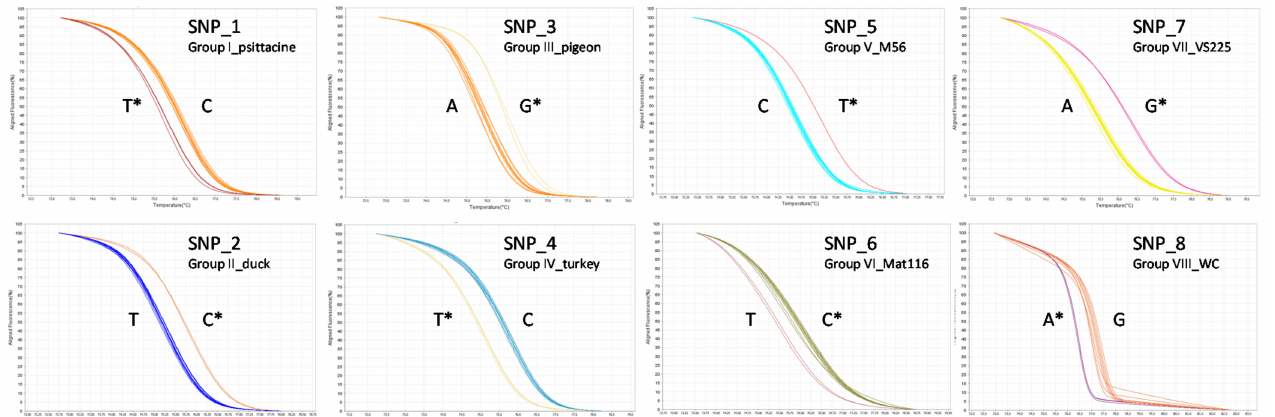
Figure 2. Normalized melting curves obtained with the eight SNP markers for reference C. psittaci strains and the respective synthetic controls. The SNP specific to the targeted group is noted by an